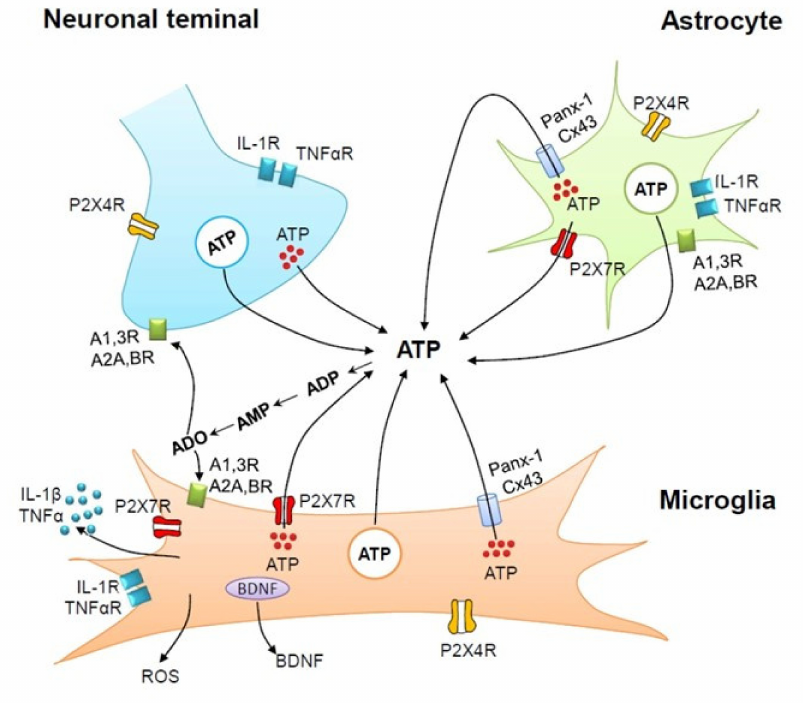
Figure 1. Purinergic receptors as well as ATP release mechanisms participating in neuron-astrocyte- microglia cross-talk. Microglia possess the ligand-gated P2X4 and P2X7 receptor subtypes as well as all subtypes of the G protein-coupled P1 (A1, A2A, A2B, A3) receptors. In addition, microglia release ATP from synaptic / lysosomal vesicles via exocytosis but also via connexin (mainly Cx43) channels and pannexin (Panx-1) hemichannels. P2X4 receptor (R) activation induces the vesicular release of brain-derived neurotrophic factor (BDNF), which causes neuropathic pain in the dorsal horn spinal cord. P2X7R activation results in the outward blebbing of the microglial plasma membrane and the production of extracellular vesicles containing interleukin-1 β (IL-1 β ). The pro-inflammatory cytokines IL-1 β and tumor necrosis factor- α (TNF α ) bind to their receptors IL-1R and TNF α R, respectively. P2X7R activation induces the di ff usion of reactive oxygen species (ROS) through the plasma membrane. All these microglial products cause neuroinflammation and neurodegeneration. Exocytotic, Ca 2 + -dependent, vesicular release occurs from neurons, astrocytes, and microglia. The vesicular release of ATP from neurons is much faster than that from astrocytes or microglia, although the vesicular proteins involved in exocytosis are relatively similar in the three cell types. ATP is rapidly degraded by ecto-nucleotidases to ADP, AMP, and eventually by 5’-nucleotidase to the bioactive adenosine (ADO). Artwork by Dr. Haiyan